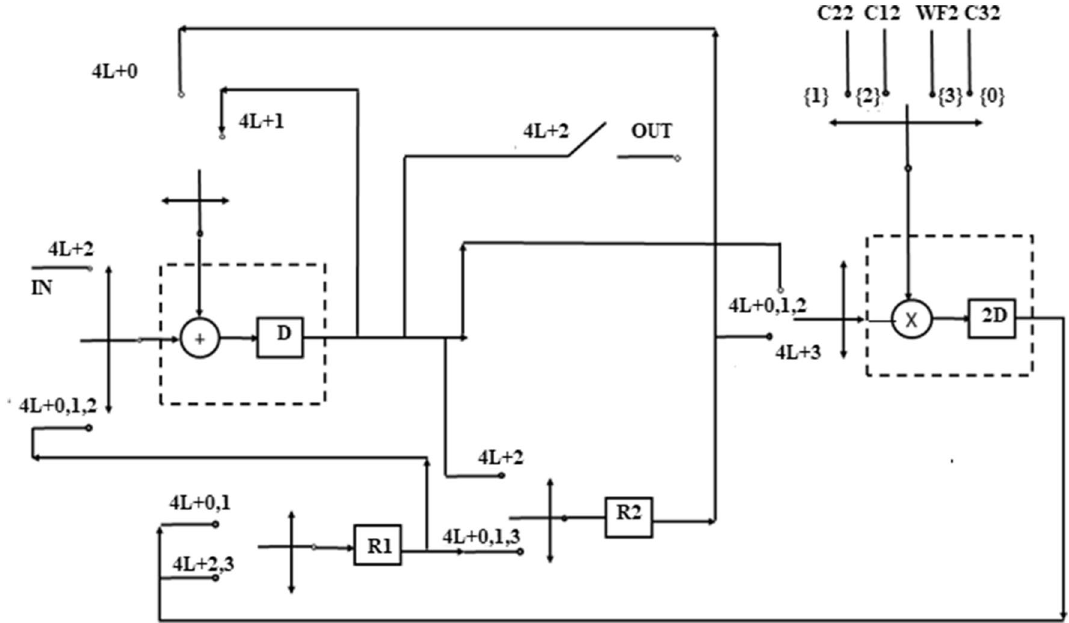
Figure 10. Folded structure of Block2 of